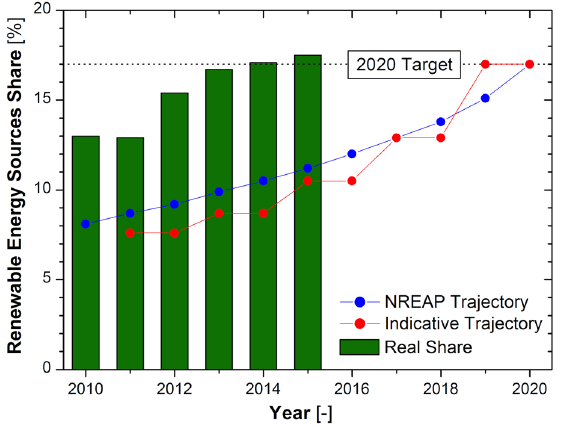
Figure 1. Italian renewable energy sources (RES) share: real, indicative, and NREAP trajectories. The actual contribution of the heat beneath the surface of solid earth to the national electric production is limited to the Toscana region (Central Italy), even though high potential exists in the rest of the Italian peninsula and specific incentives are defined by the national legislation [14–16].